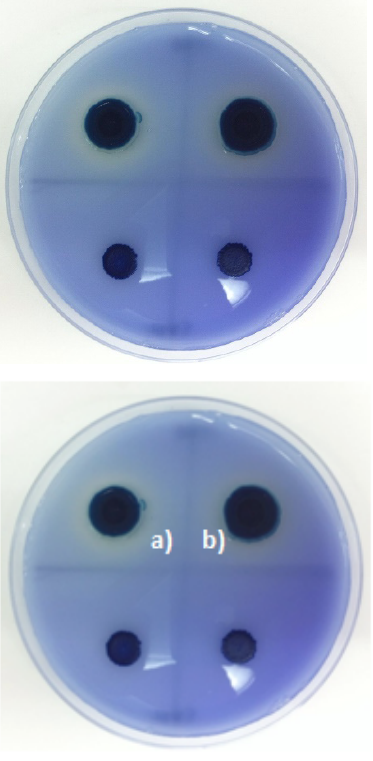
Figure 3: Phosphate solubilization results for a) OSM10 and b) OSM13 strains isolated from agricultural